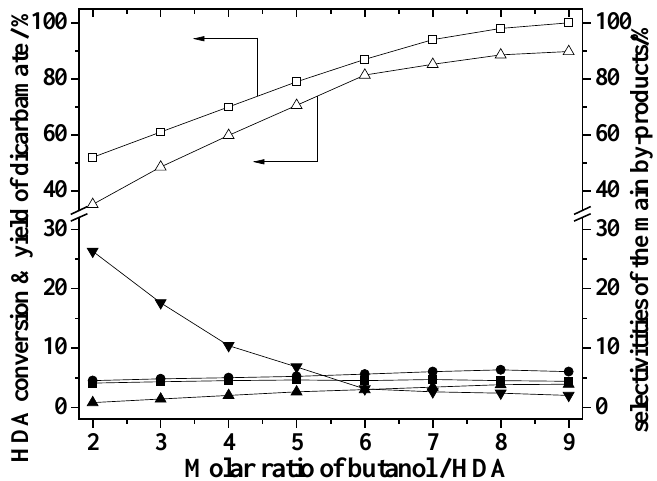
Figure 4. Effect of molar ratio butanol/HDA on HDA conversion, yield of 2 and selectivities for the main byproducts ( 1 , 3 – 5 ). Reaction conditions: HDA: 0.9 mol; ZnAlPO 4 : 3.0 g; urea: 2.34 mol;